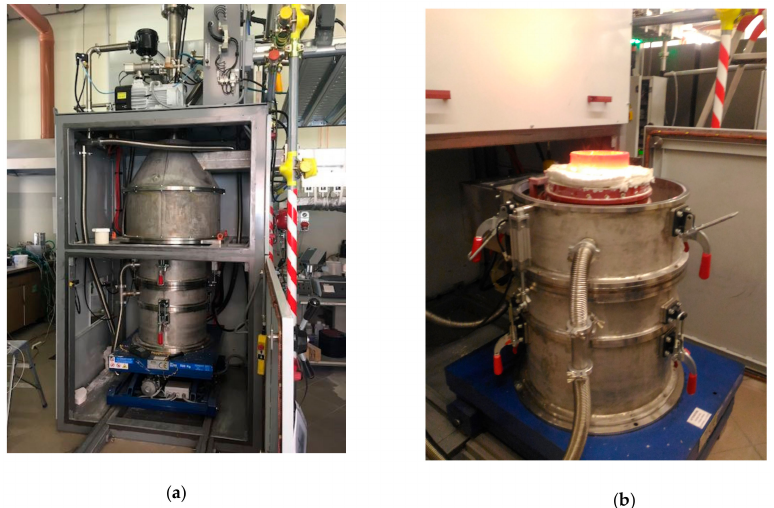
Figure 10. Prototype ( a ) with outer Faraday cage removed, showing on the top the microwave applicator fed through the waveguide on the right ( b ) with hot crucible and induction part removed from the bottom by a shifting mechanism.